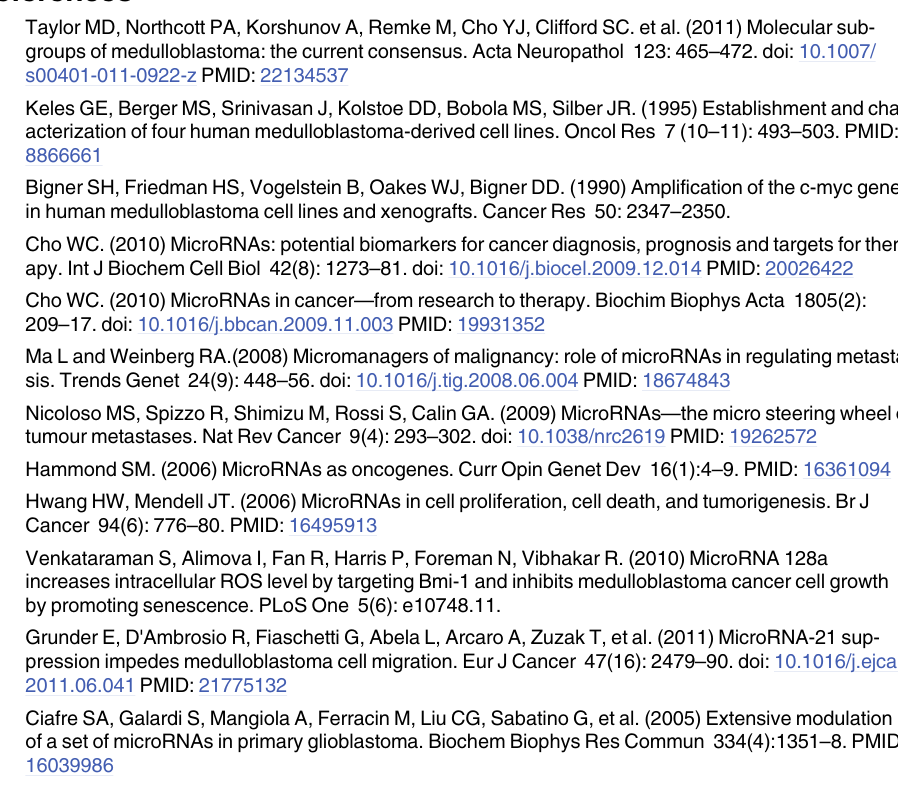
S2 Fig. The effect of BCL2 inhibition is specific to miRNA-10b. Medulloblastoma cells (DAOY) were incubated with the BCL2 inhibitors ABT-737 and ABT-199 for 48 hours. DMSO 0.1% was used as control treatment. Total RNA was extracted from DAOY cells and subjected to RT-PCR for the analysis of (A) miRNA-17 and (B) miRNA-20b expression under the influence of BCL2 inhibitors ABT-737 and ABT-199. Error bars represent SD from the mean from at least 4 repeat experiments. This demonstrates that the effect of BCL2 inhibition on miRNA-10b is specific to